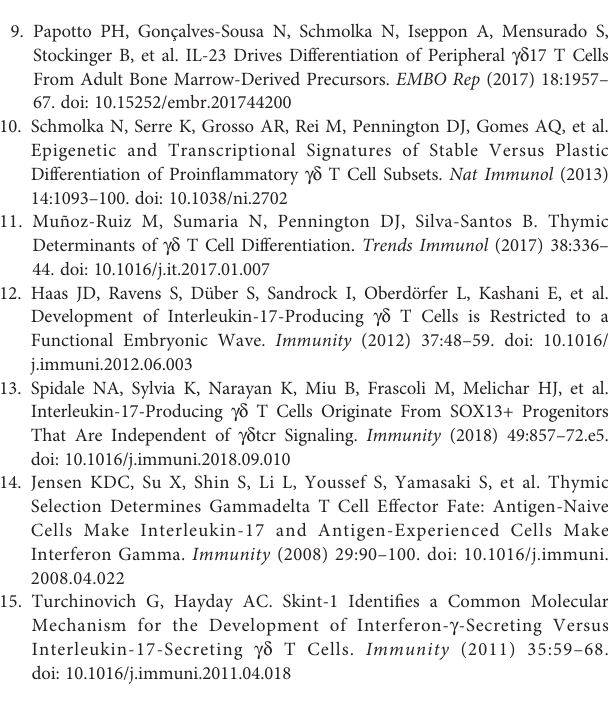
Supplementary Figure 1 | Attenuation of IMQ-induced psoriasis-like lesions in KI-PRS mice. KI-PRS and WT littermates were treated with Imiquimod (IMQ) for 7 days on ears and shaved backs, or leftuntreated (NT). On day 7, back skin sections weresubjectedtohematoxylinandeosin(H/E)stainingformicroscopyanalysis.The thickness of the epidermal layer was measured at multiple sections and sites, randomly chosen in a blind manner. The fi gure shows representative sections of H/ E staining in the indicated conditions. Supplementary Figure 2 | Gating strategy for skin TCR gd analysis. Representative dot plots show full gating strategy for skin TCR gd analysis. Supplementary Figure 3 | Gating strategy for skin myeloid in fi ltrate. Representative dot plots show full gating strategy for skin myeloid in fi ltrate analysis. Supplementary Figure 4 | IMQ-induced myeloid in fi ltrate in skin. KI-PRS and WT littermates were treated with Imiquimod (IMQ) for 7 days on ears and shaved backs, or left untreated (NT). On day 7, ears were processed for the analysis of myeloid cell in fi ltration by fl ow cytometry. Graphs represent the frequency (left) and absolute cell number (right) of the indicated cell populations. (B) CD45.2 pos cells. (C) Myeloid cells, gated as CD11b pos . (D) Dendritic cells, gated as CD11c pos . (E) Neutrophils, gated as CD11b pos Ly6C neg Ly6G pos . (F) In fl ammatory monocyte-macrophages, gated as CD11b pos Ly6C pos Ly6G neg . (G) Resident monocytes, gated as CD11b pos Ly6C neg Ly6G neg . Statistical analysis was performed using Mann-Whitney t-test. ns, non signi fi cant. Data are representative of 2 independent